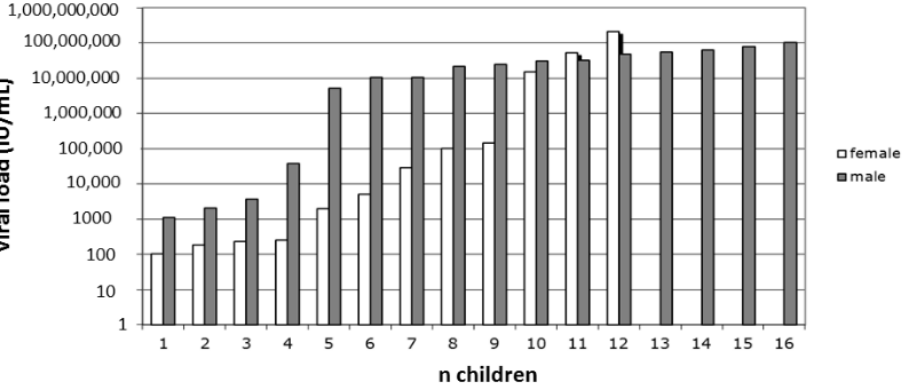
Figure 1. Distribution of HBV viral load in 12 female and 16 male Ghanaian children <5 years. Grey bars indicate male children and open bars female children.